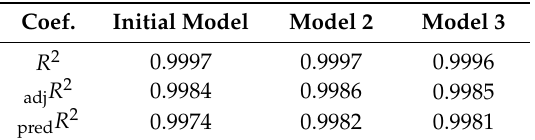
Table 8. Significance and predictive capability of the regression models.